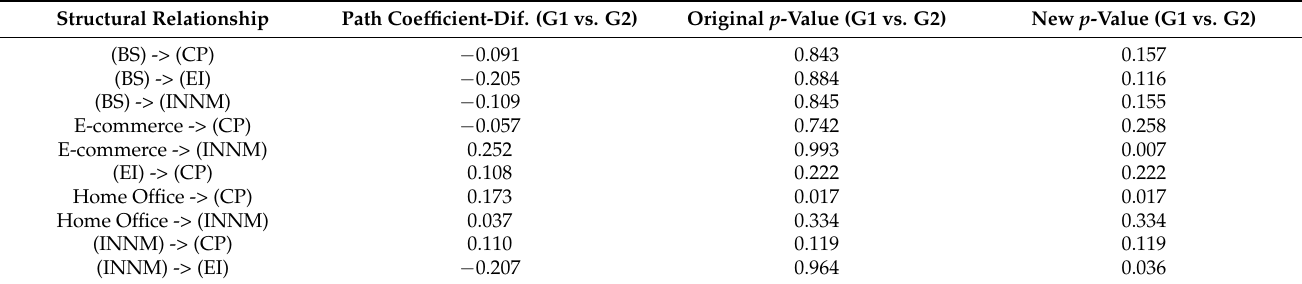
Table 8. PLS-MGA.